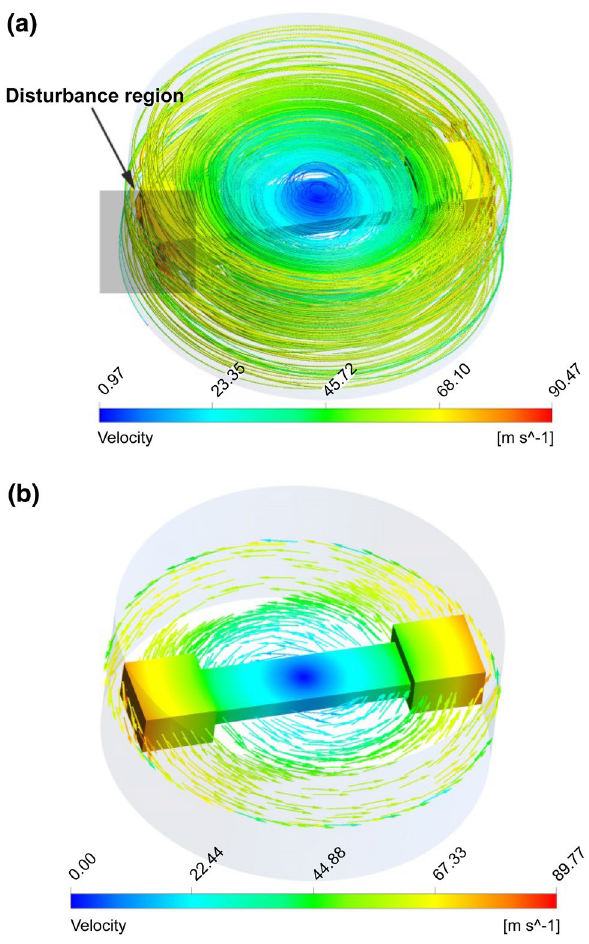
Fig. 5 a Streamline diagram at an acceleration of 120 g and b velocity vector diagram at an acceleration of 120 g